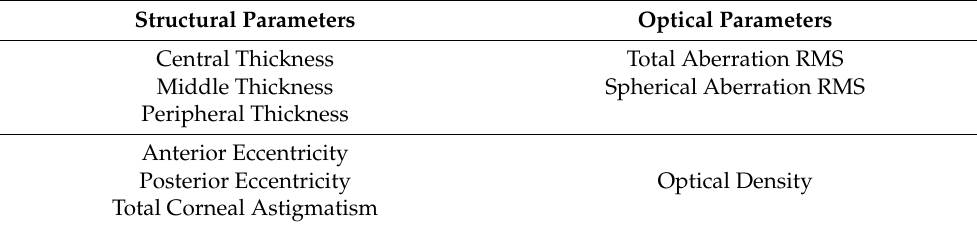
Figure 1. Total corneal wavefront aberration map ( left ) and anterior segment Scheimpflug image ( right ) from a volunteer of the study. Table 1. Structural and optical parameters from the Galilei system considered of interest in our study. The total and spherical aberration wavefront were numerically evaluated by its root mean square (RMS) value.